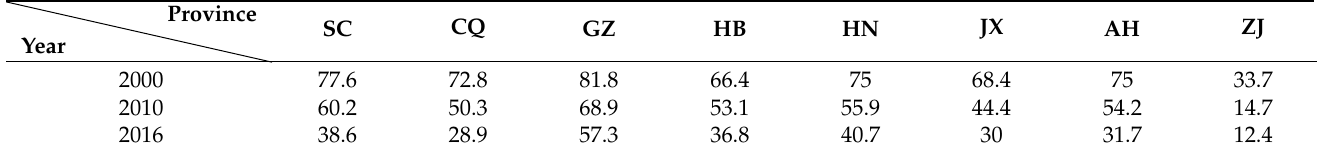
Table 2. Proportion of agricultural employees in the total population